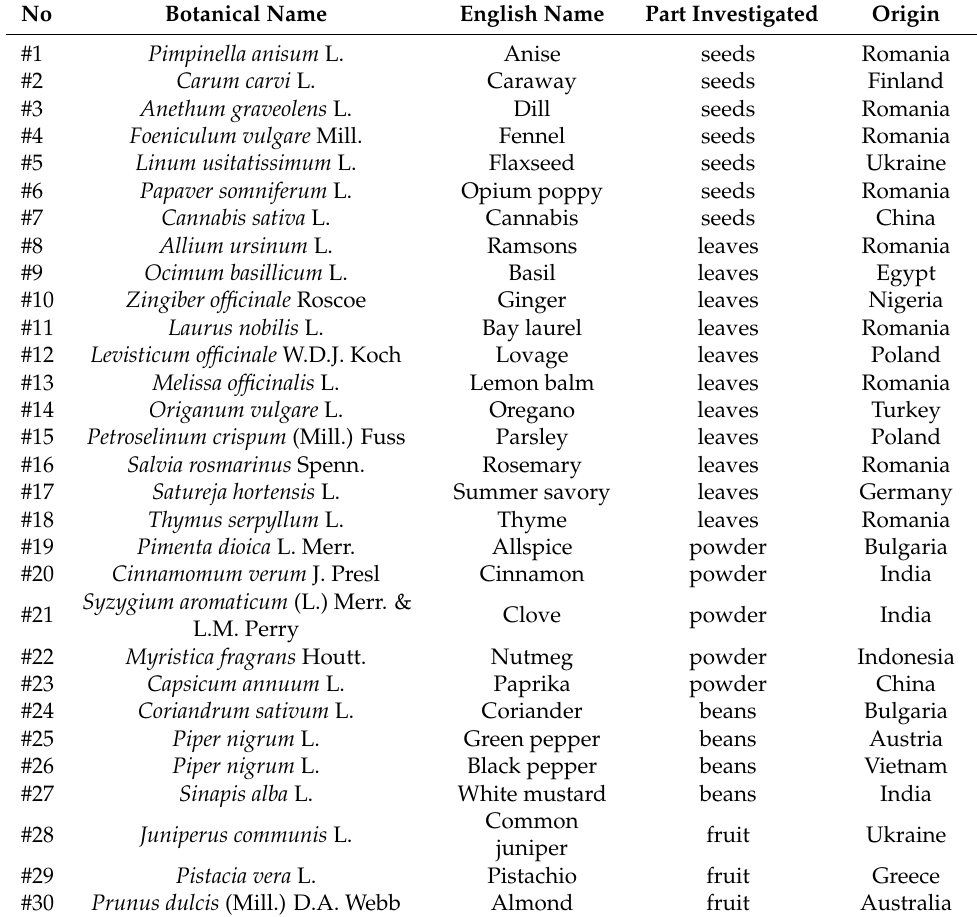
Table 3. List of aromatic spices